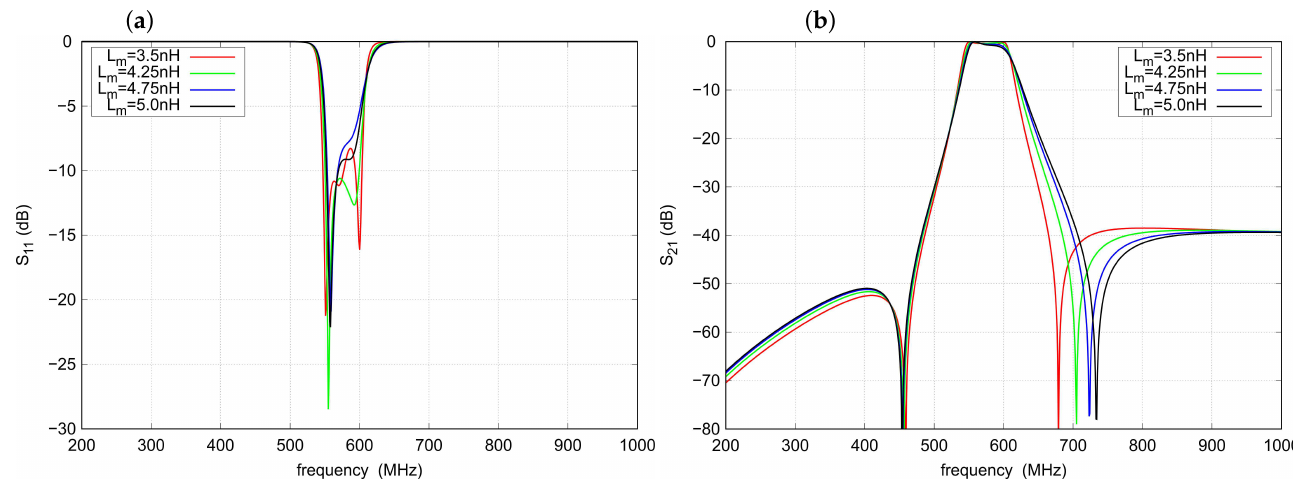
Figure 7. Influence of the L m inductance on the filter response: ( a ) s 11 parameter, ( b ) s 21 parameter.